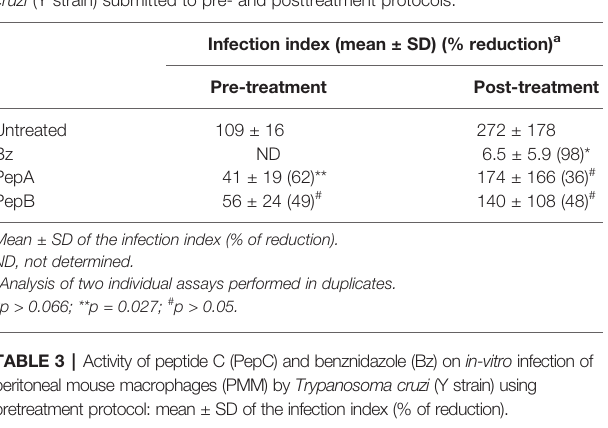
TABLE 4 | Activity of peptides A and B and benznidazole (Bz) on in-vitro infection of cardiac cell cultures by Trypanosoma cruzi (Y strain) using pre- and